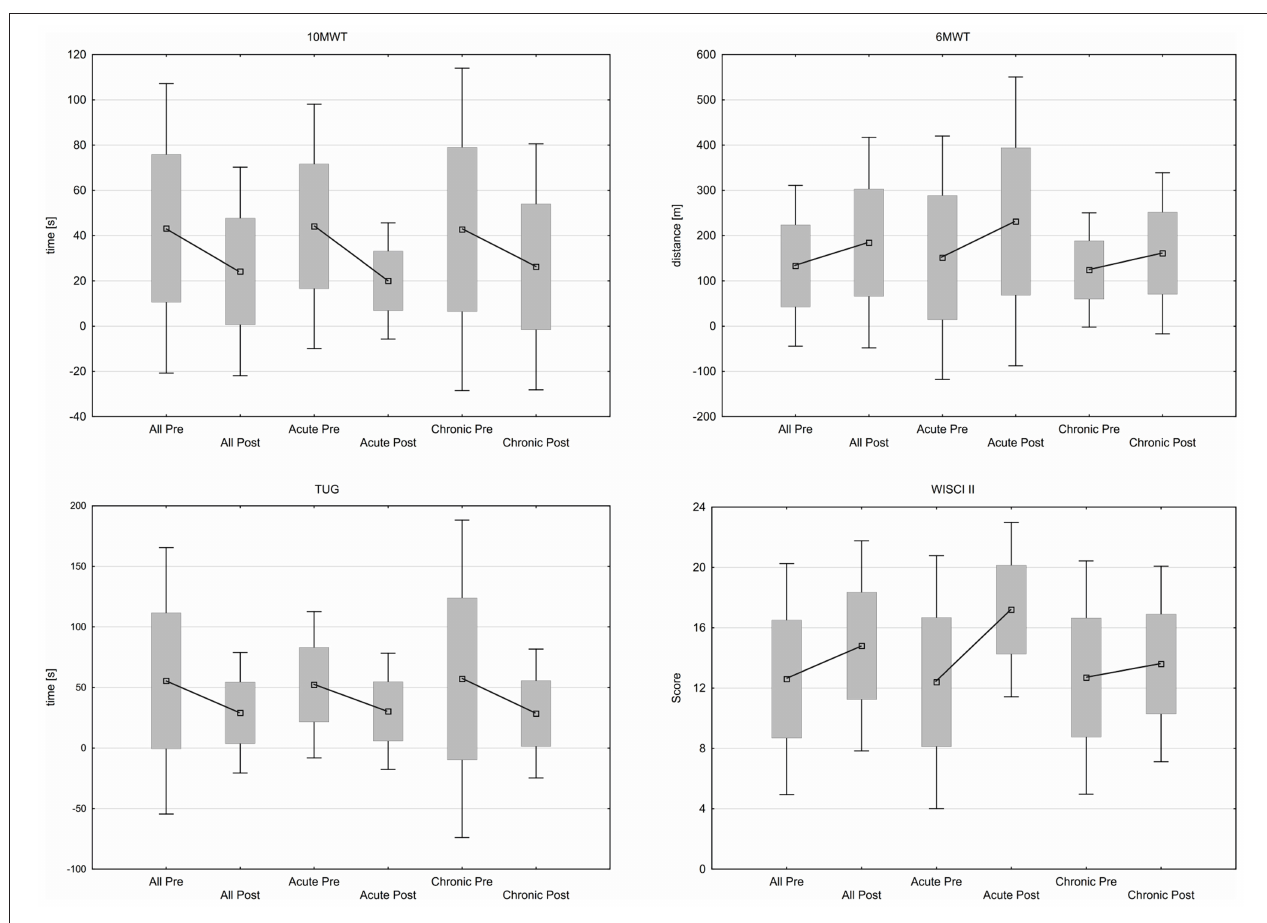
FIGURE 4 | Functional outcome in 10MWT, 6MWT, TUG, WISCI II